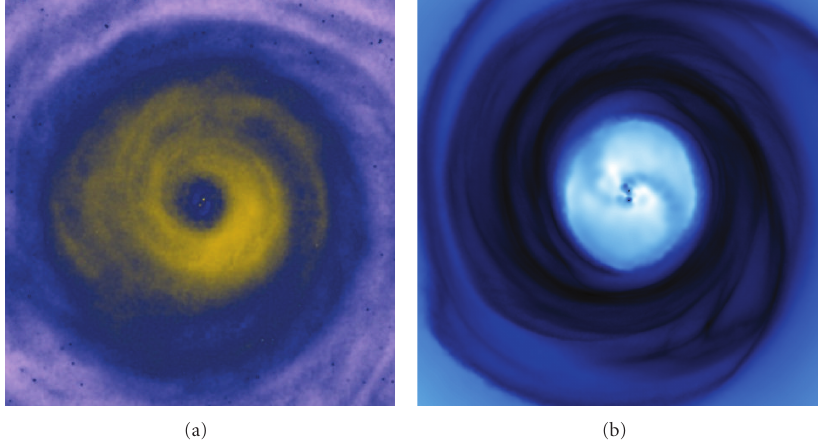
Figure 2: Two consecutive stages of the MBHB decay in the nucleus of a gas-rich galaxy merger remnant. (a) Central region ( ∼ 5pc) of a large-scale (100pc) massive (10 8 M (cid:2) ) circumnuclear disk, embedding a sub-pc MBHB (from one of the simulations in [56]). The color code refers to the gas density (high densities in yellow). (b) an eccentric MBHB embedded in a sub-pc circumbinary disk (from [62]). Here, darker blue refers to higher